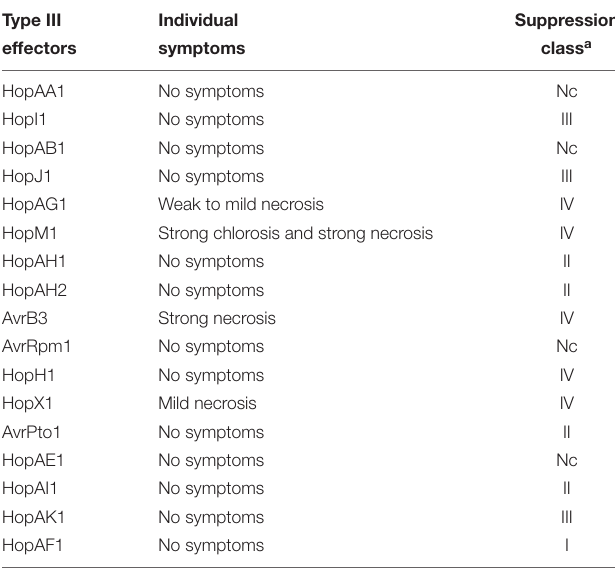
TABLE 1 | Psy B728a type III effectors tested for their ability to suppress HopZ3-dependent necrosis in bean elicited in Agrobacterium tumefasciens -mediated transient expression